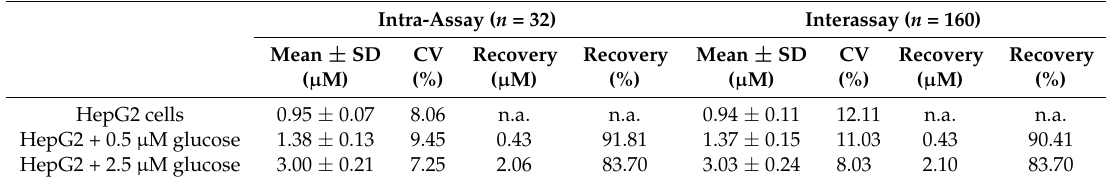
Table 2. Intra- and interassay imprecision and recovery of the glucose assay in HepG2 cell cultures.